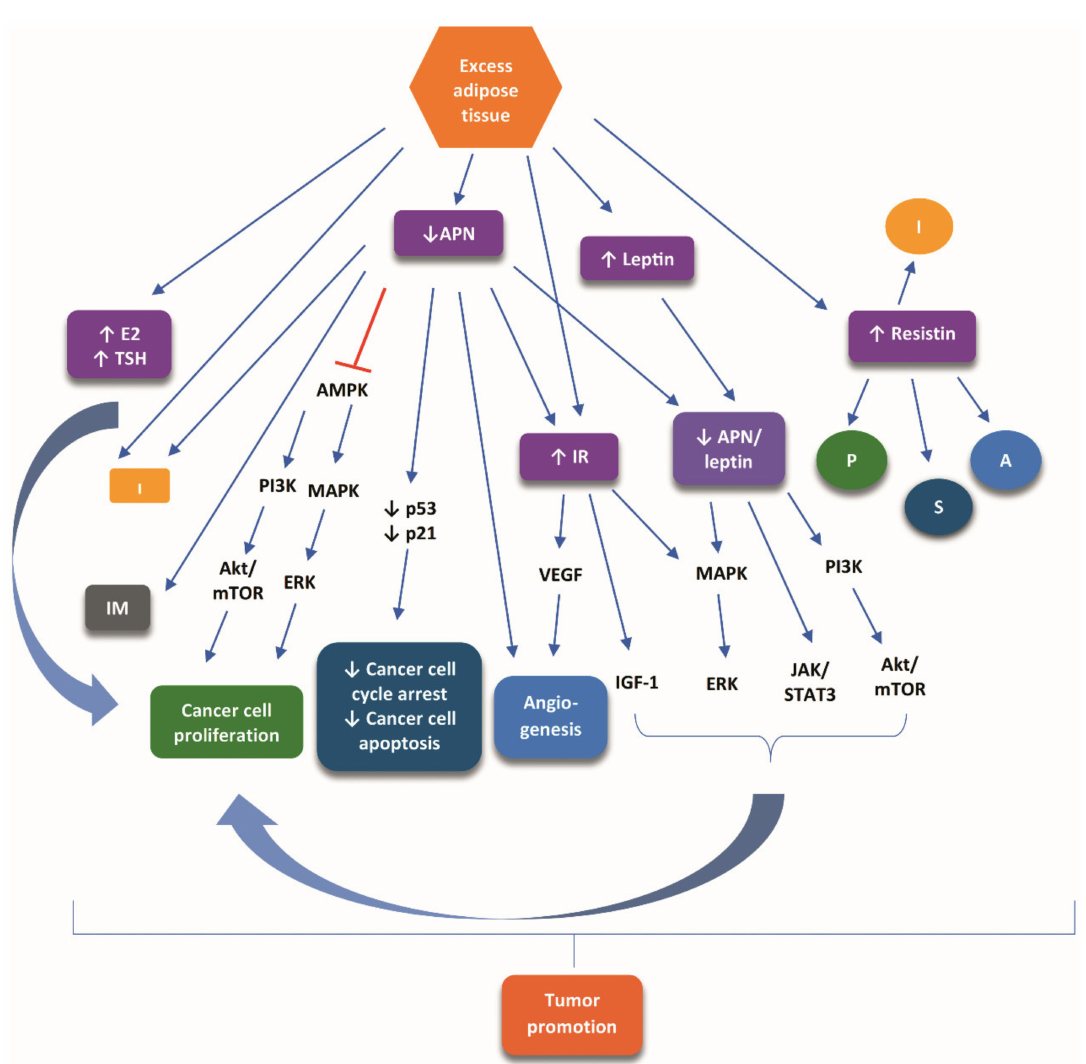
Figure 1. The main signaling pathways presumed to mediate the tumor-promoting role of obesity in TC. Excess adipose tissue causes an increase in TSH and 17- β -estradiol, decrease of adiponectin, insulin resistance, and increase of leptin and resistin. These alterations modulate numerous signaling cascades, which crosstalk and result in tumor promotion. Symbols: increase: ↑ ; inhibiton: ; stimulation: . Abbreviations: A, angiogenesis; Akt, protein kinase B; AMPK, adenosine monophosphate-activated protein kinase; APN, adiponectin; E2, 17- β -estradiol; ERK, extracellular signal-regulated kinases; I, inflammation; IGF-1, insulin-like growth factor 1; IM, inflammatory-immune responses; IR, insulin resistance; JAK, MAPK; mitogen-activated protein kinase; mTOR, mammalian target of rapamycin; P, proliferation; PI3K, phosphoinositide-3 kinase; S, survival; STAT3, signal transducer and activator of transcription 3; TSH, thyroid-stimulating hormone; VEGF, vascular endothelial growth